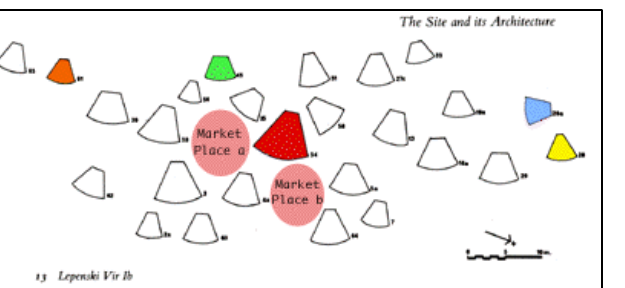
Figure 13. Lepenski Vir Ib with the presentation of the layout of the dwellings and their bases and purposes. Significant dwelling No. 54 was painted red, dwelling No. 28, "the sanctuary under the walls", was painted yellow, dwelling No. 26 which is oriented north south is coloured blue, dwelling No. 45, for which an altar carved in the shape of a fish, between the centre and the stone table, is painted green, and dwelling No. 61, which had its grave in its frame, it was painted brown. Two pink coloured areas may have been intended for trade, or public ceremonies. They are both on the main passages and they are easily connected in